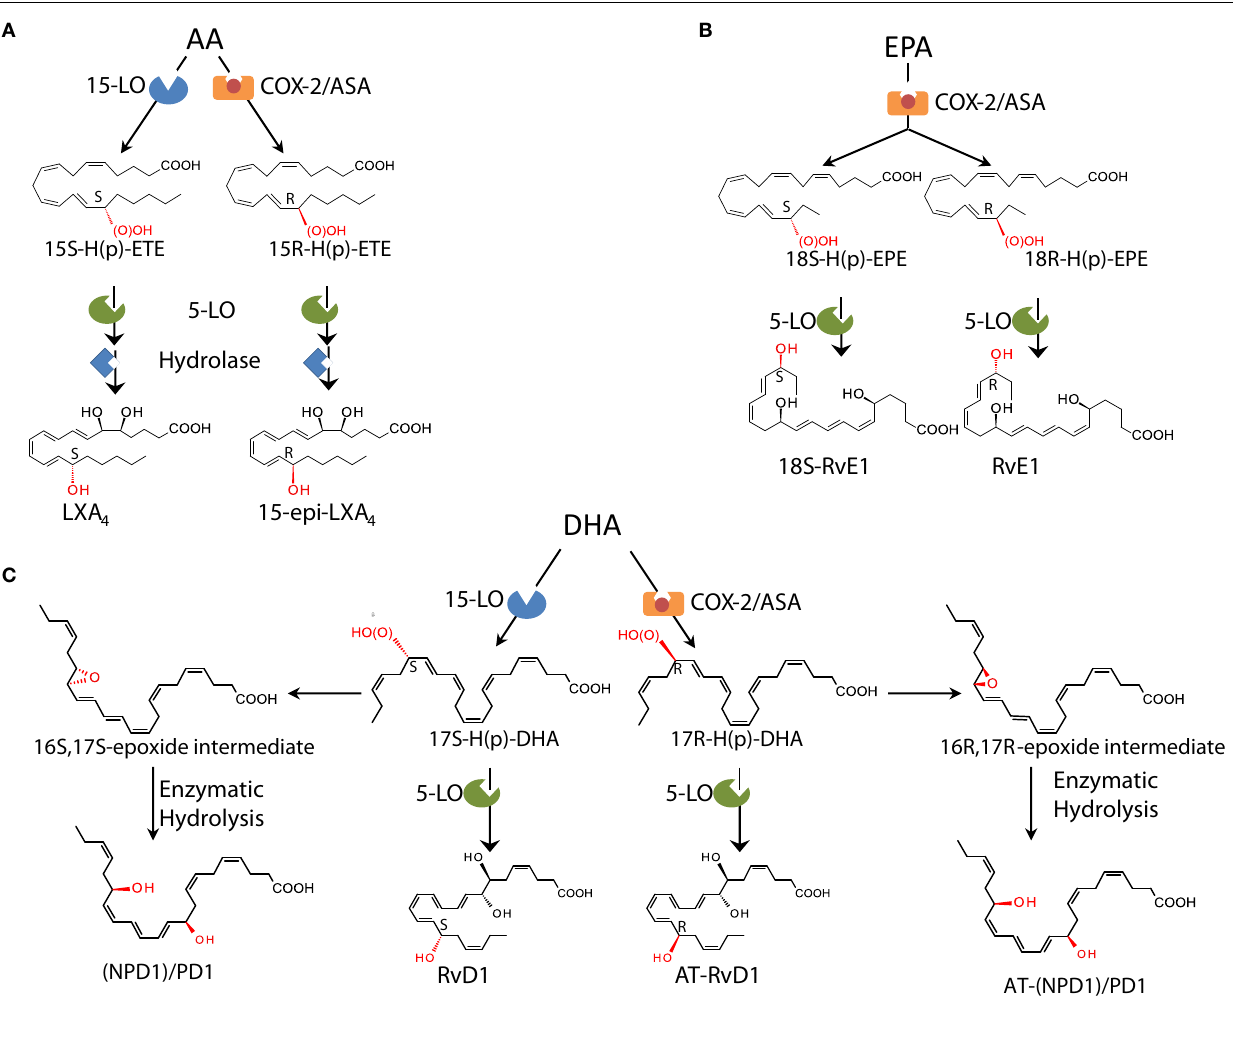
FIGURE 3 | Biosynthetic schemes of SPM. (A) In humans, AA can be converted into 15S-H(p)-ETE through 15-LO and into 15R-H(p)-ETE by aspirin (ASA)-acetylated COX-2. Both intermediates can be further metabolized through 5-LO and enzymatic hydrolysis yielding LXA4 or 15-epi-LXA4. (B) E-series resolvins are biosynthesized via conversion of EPA by ASA-acetylated COX-2. Products of these reactions, 18S-H(p)-EPE and 18R-H(p)-EPE, are rapidly taken up by 5-LO and converted to 18S-RvE1 and RvE1. (C) The DHA metabolome